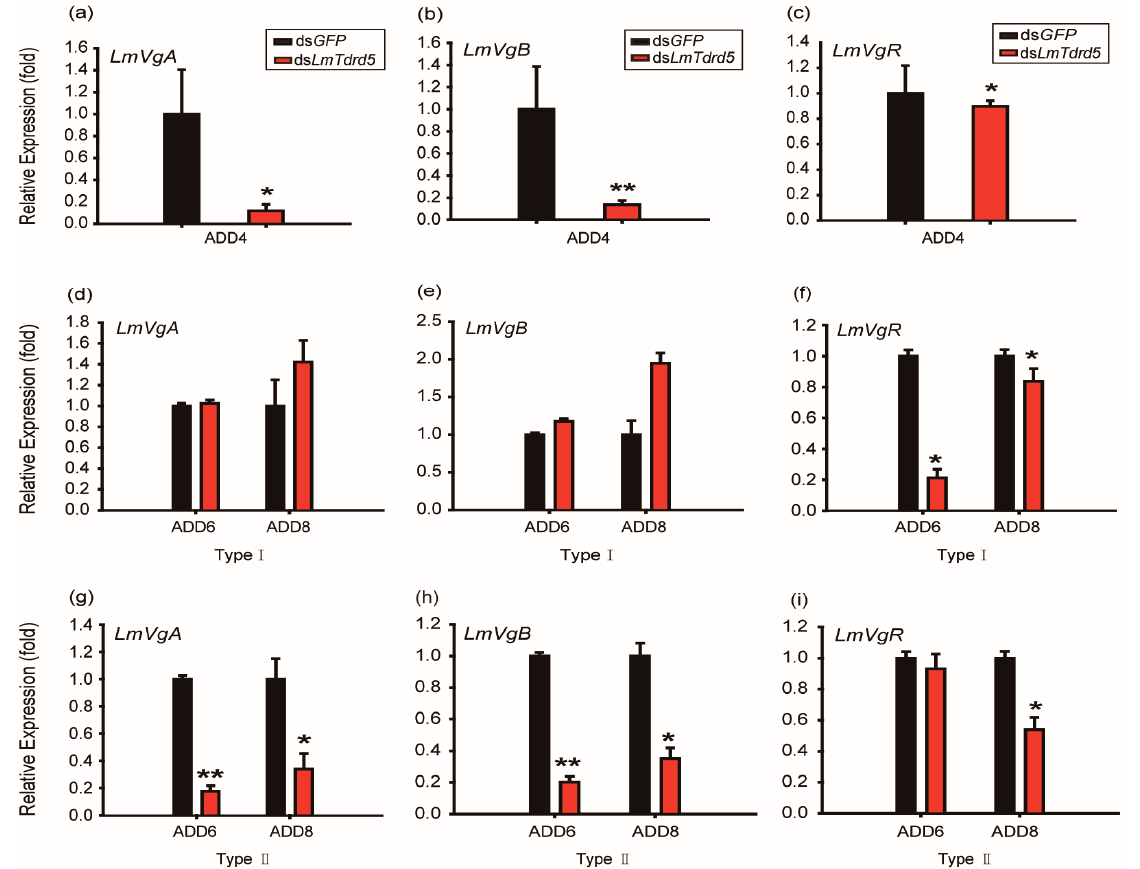
Figure 5. Effect of ds LmTdrd5 injection on the transcript levels of vitellogenin ( Vg ) and its receptor. ( a – c ) Relative expression levels (fold) of LmVgA ( a ), LmVgB ( b ), and LmVgR ( c ) in the fat bodies and ovaries in locusts at ADD4. ( d – f ) Type I: Relative expression levels (fold) of LmVgA ( d ), LmVgB ( e ), and LmVgR ( f ) at ADD6 and ADD8. ( g – i ) Type II: Relative expression levels (fold) of LmVgA ( g ), LmVgB ( h ), and LmVgR ( i ) at ADD6 and ADD8. Data in all panels are presented as mean ± standard error of the mean ( n = 9–15). Statistically significant differences are indicated as follows: * p <